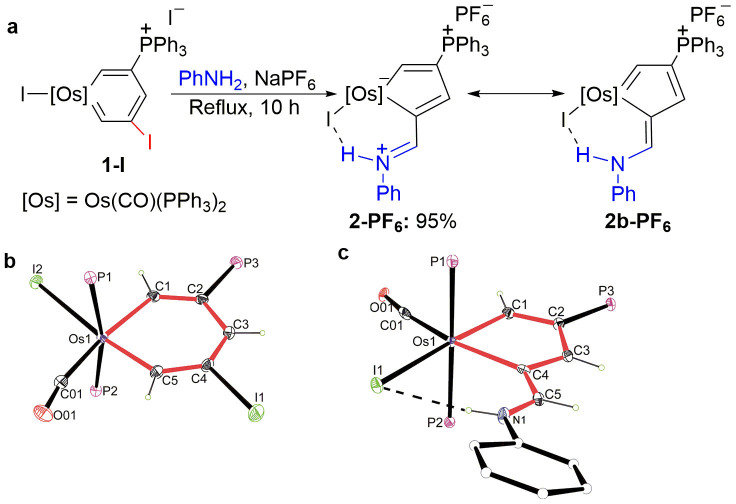
Synthesis of osmacyclopentadiene 2-PF6.(a) The reaction of osmabenzene 1-I with aniline produces osmacyclopentadiene 2-PF6. (b, c) X-ray structures of 1-I (b) and 2-PF6 (c) (50% probability level). Phenyl moieties in PPh3, the counter anion and the solvent molecules have been omitted for clarity. Selected bond lengths (Å) for 1-I: Os1-C1 2.065(7), Os1-C5 1.956(7), C1-C2 1.359(10), C2-C3 1.432(11), C3-C4 1.345(10), C4-C5 1.407(11), C4-I1 2.131(7), Os1-C01 1.925(8), C01-O01 1.145(9), Os1-I2 2.8161(8). Selected bond lengths (Å) for 2-PF6: Os1-C1 2.004(6), Os1-C4 2.183(7), Os1-I1 2.8347(5), C1-C2 1.372(9), C2-C3 1.430(9), C3-C4 1.386(9), C4-C5 1.418(9), C5-N1 1.309(8), Os1-C01 1.880(9), C01-O01 1.109(8).